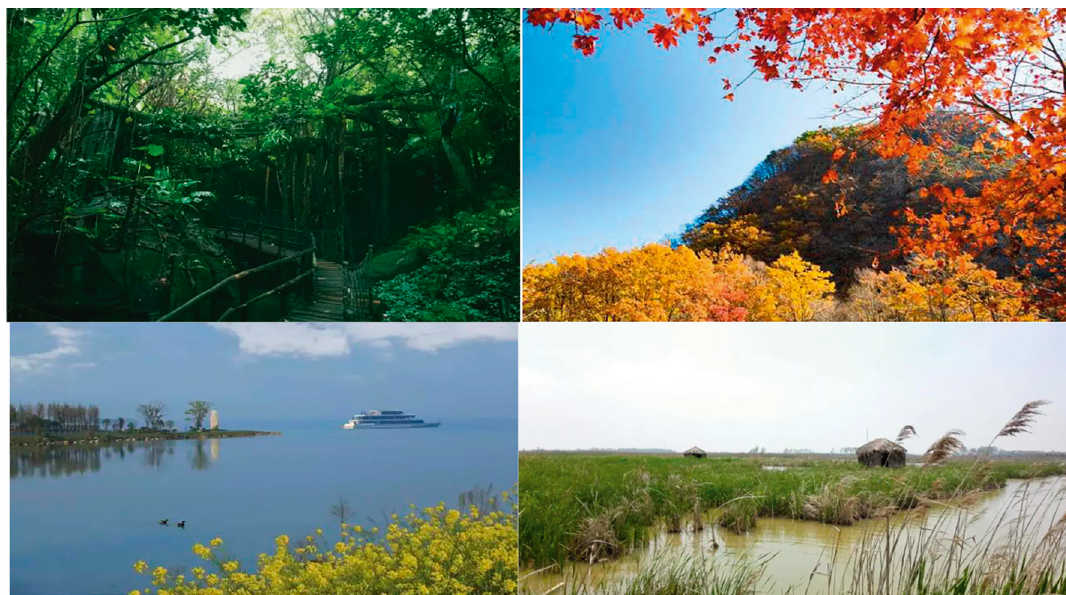
Figure 1: Village tourism map of a typical township.